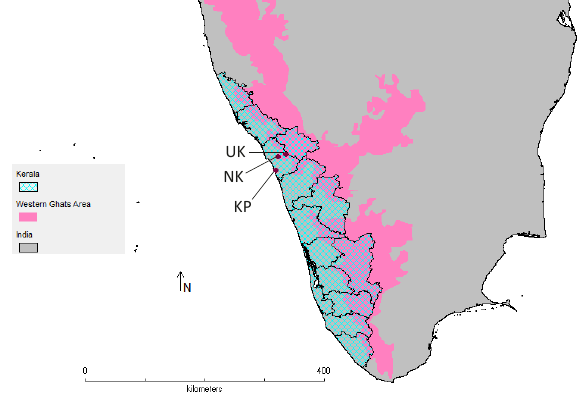
Figure 1. Study areas for ecological studies Site 1: Protected forest ecosystem: Urakkauzhy (UK); Site 2 - undisturbed & isolated hilly area: Narayamkulam (NK); Site 3 - Residential land: Kuttothparambu (KP)